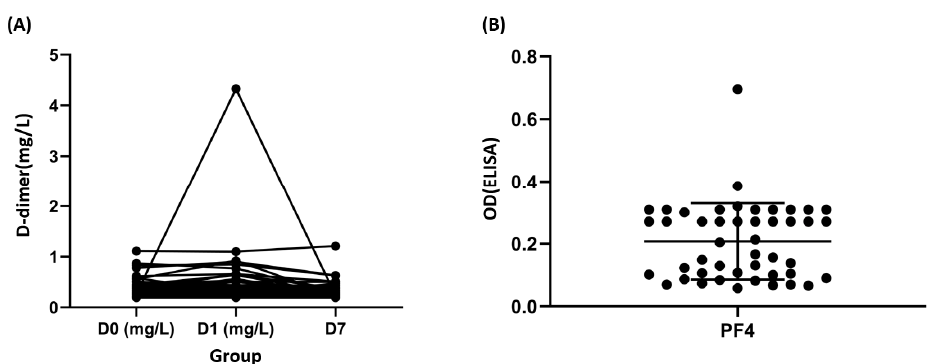
Figure 1. Laboratory characteristics in response to ChAdOx1 nCoV-19 immunization. ( A ) Dynamic changes in the D-dimer levels in donors with ChAdOx1 nCoV-19 vaccination. ( B ) Platelet factor 4 (PF4) optical densities were measured in the plasma of donors. OD: optical density, positivity threshold: OD ≥ 0.4; ELISA: Enzyme-linked immunosorbent assay HAT45G ®® .